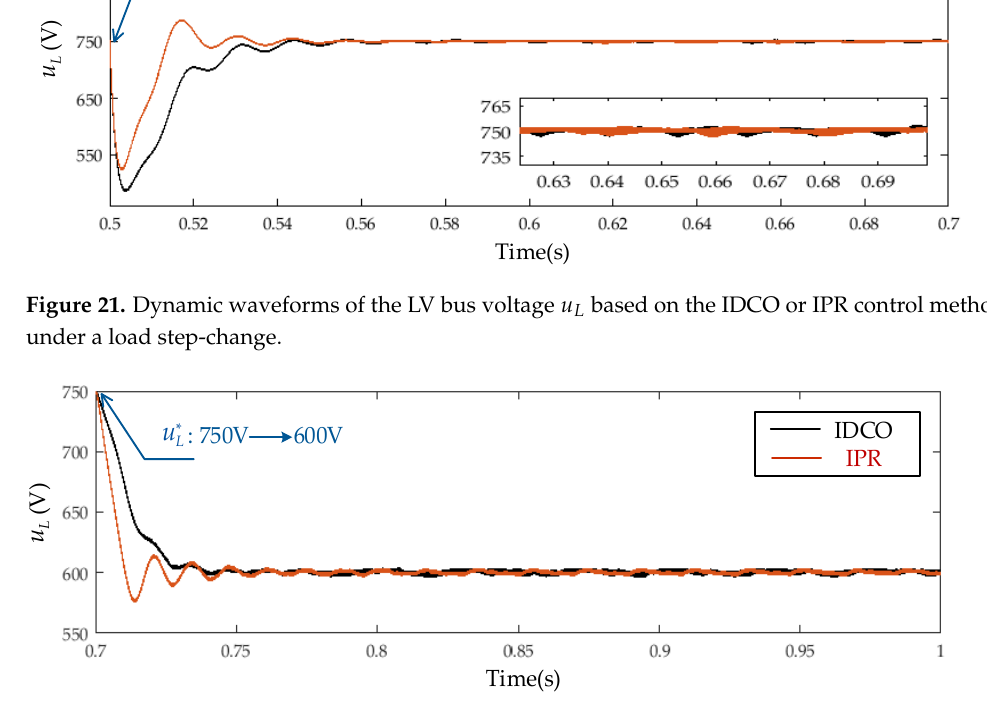
u based on the IDCO or IPR control L